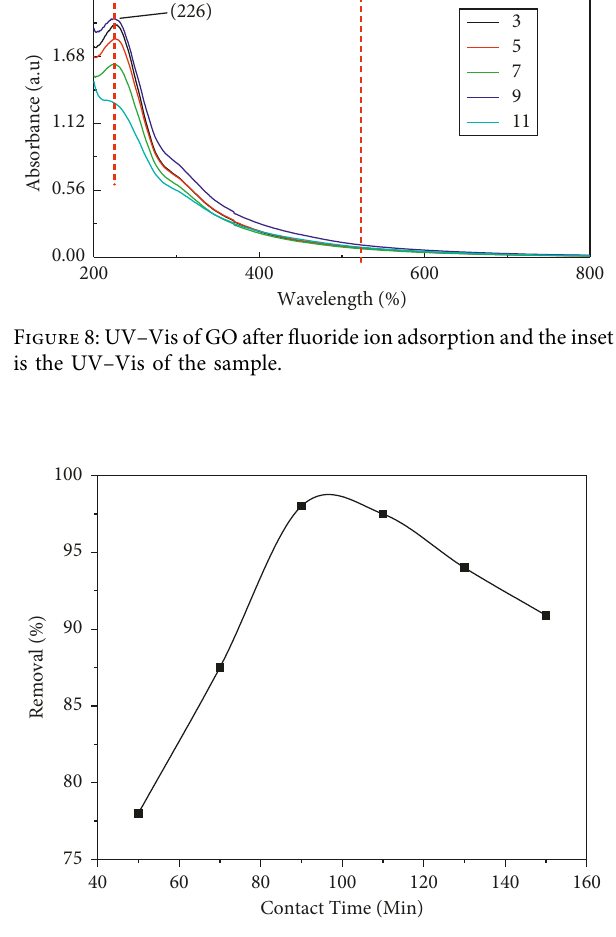
Figure 7: Effect of pH on the removal of F − obtained from groundwater.